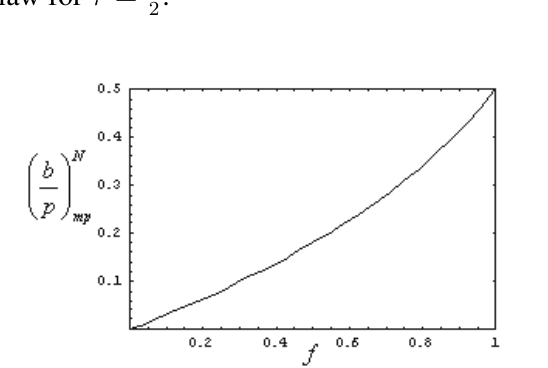
Figure 5. Quotient between the price parameters a Newton heat transfer law for τ = 1